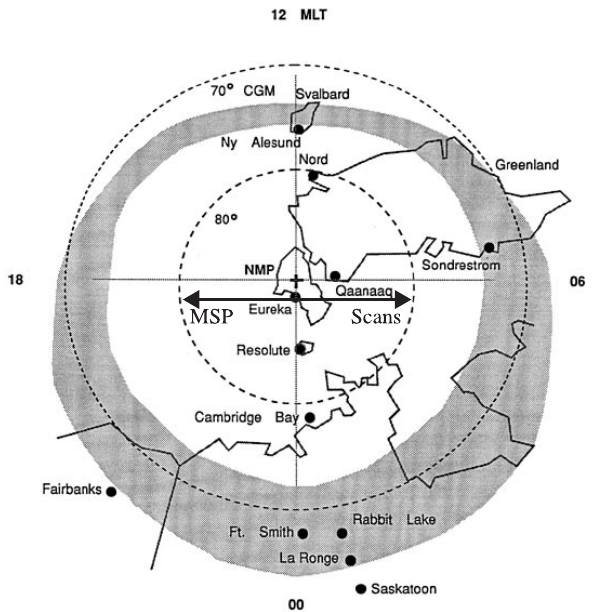
Fig. 1. A sketch of the auroral oval and location of Eureka (89 (cid:14) CGM). The north magnetic pole ( NMP ) is at the